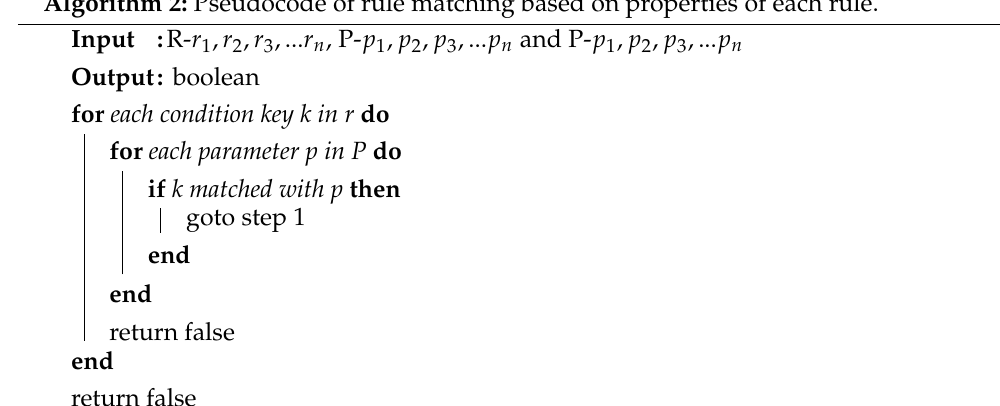
Algorithm 2: Pseudocode of rule matching based on properties of each